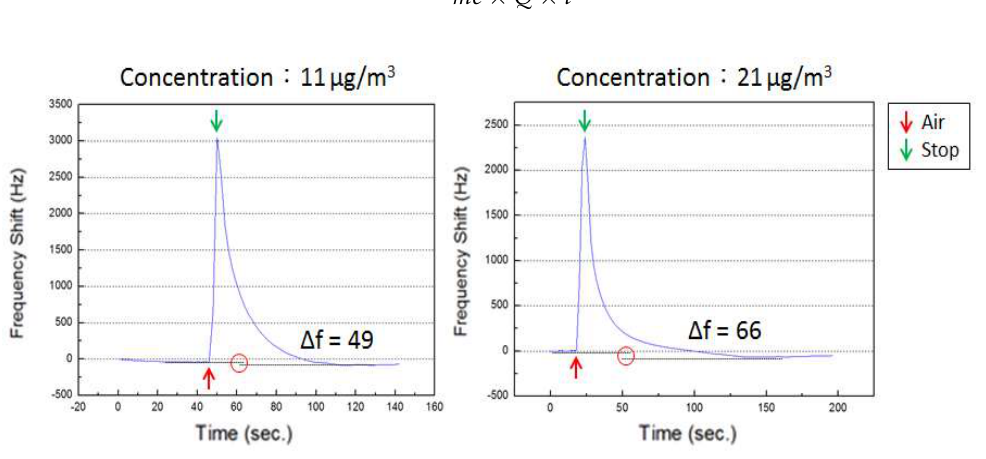
Figure 7. Frequency response curve of the SH-SAW sensor to incense smoke at varied concentration.